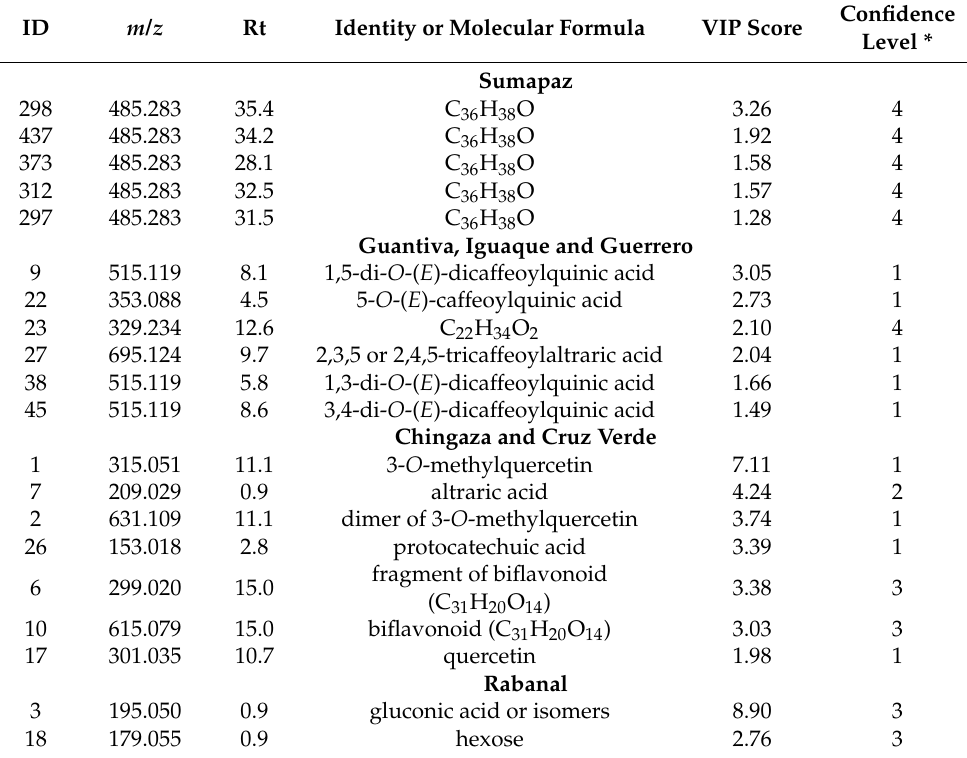
Table 3. Discriminant metabolites of the p á ramo complex of origin of 25 individuals of Espeletia selected by the analysis of the orthogonal partial least squares discriminant analysis (OPLS-DA) loadings plot and variable importance in the projection (VIP) scores (Figure 4d). Metabolites are sorted by their VIP score. See Supplementary Materials for compounds